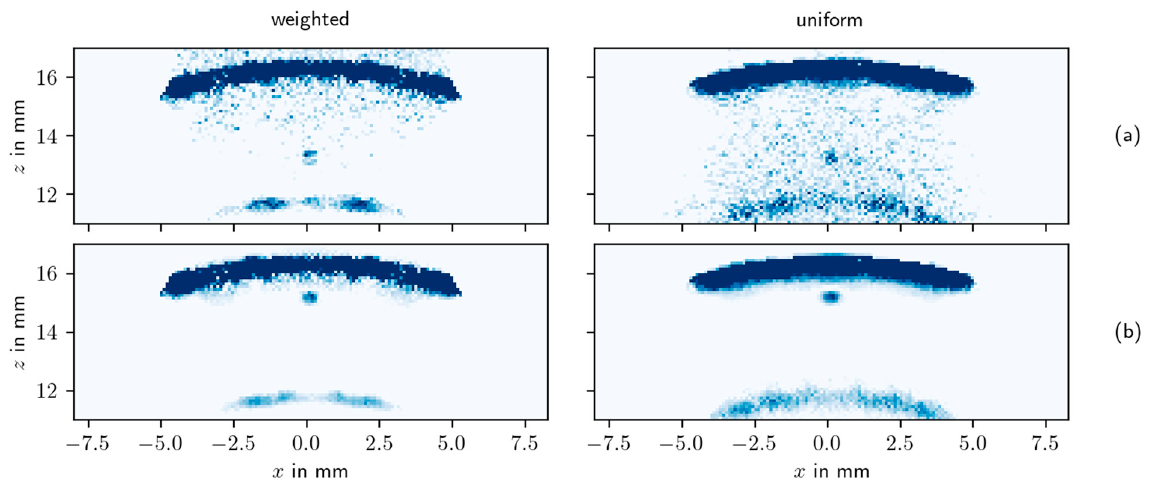
Figure 8. B-scan views of FISTA reconstructions for four transducer elements comparing the weighting scheme given in Equation (7) with a uniform weighting, i.e., W = I , for ( a ) a defect at z = 13mm and ( b ) z = 15mm, respectively. All plots are normalized such that the colormap spans the values from zero to the maximum amplitude of the respective scatterer.